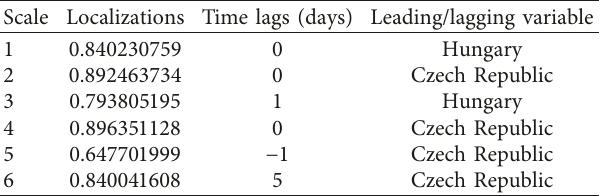
Table 7: Wavelet multiple cross correlations (WMCC). Scale Localizations Time lags